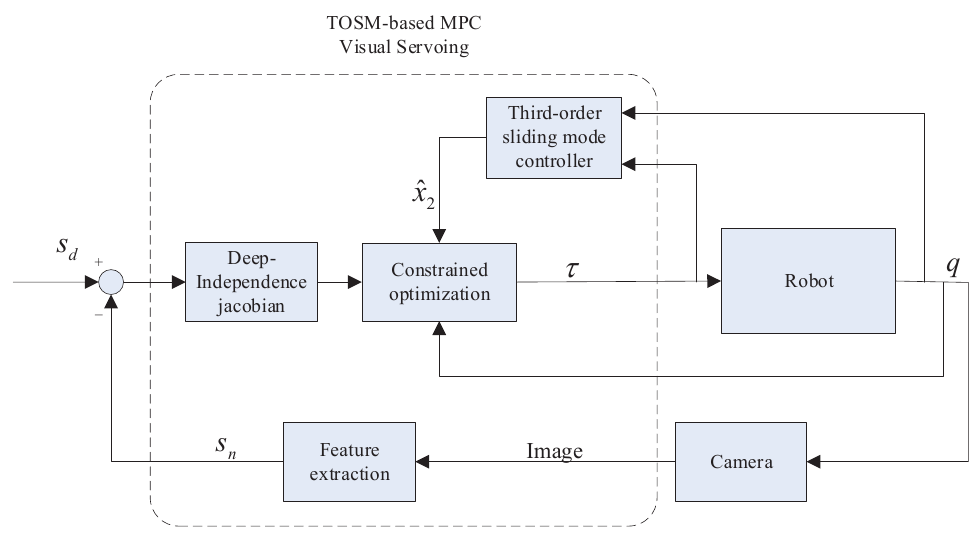
Figure 3. The control system